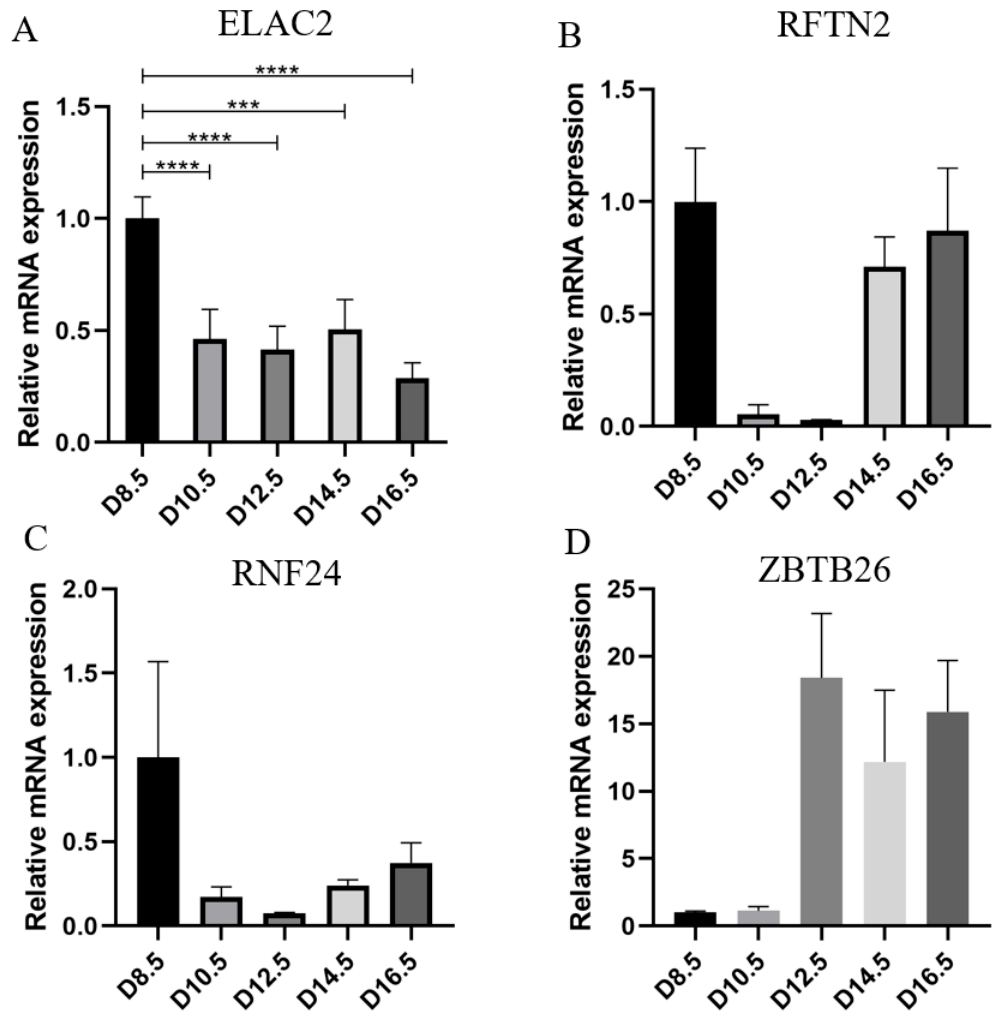
Figure 5. Detection of gene expression in mouse placenta at different developmental stage. ( A ) Detection of ELAC2 mRNA expression by qPCR. ( B ) Detection of RFTN2 mRNA expression by qPCR. ( C ) Detection of RNF24 mRNA expression by qPCR. ( D ) Detection of ZBTB26 mRNA expression by qPCR. *** p < 0.001, **** p <